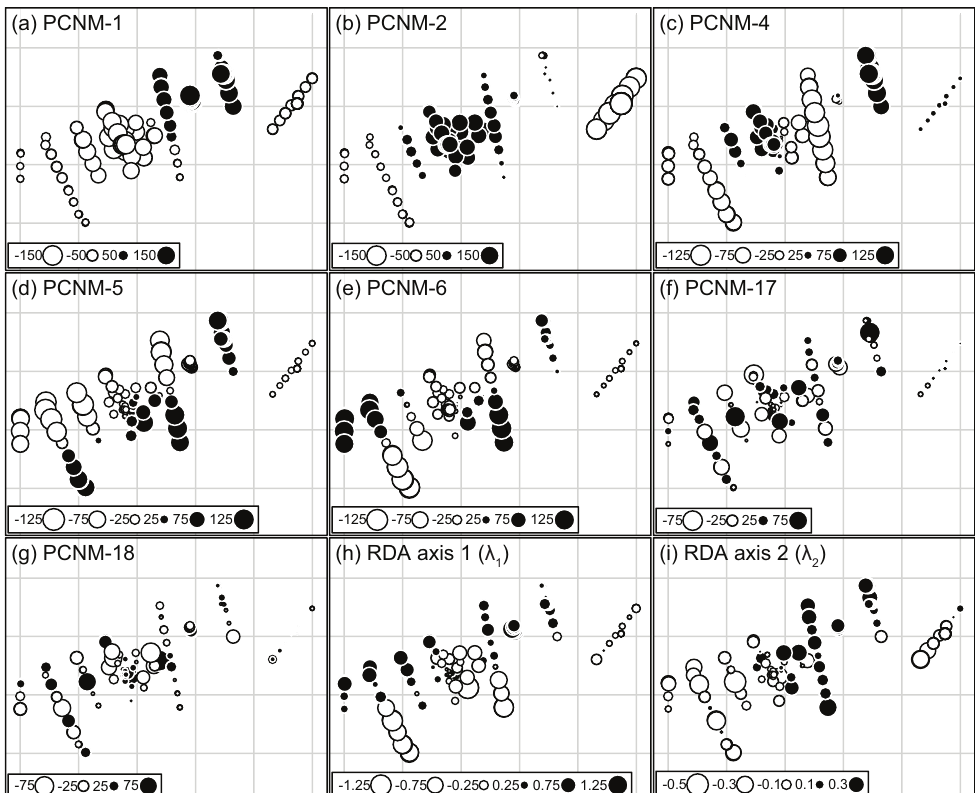
Fig. 15. Maps of (a–g) the seven significant PCNM functions obtained from the analysis between the Euclidean station distance matrix and the vertical POC flux size classes (i.e., used as “species”), and resulting from the forward selection of 25 initial PCNM variables with positive spatial correlation (i.e., positive Moran’s I , across a range of broad-to-fine scales). Maps of (h–i) the fitted scores of the first two canonical axes from the redundancy analysis (representing 44.5% and 5.0% of the total PCNM variance) performed between the POC flux size classes, station locations, and the significant PCNM functions (Fig. 14b). The station locations across the maps correspond to their geographical position as illustrated in Fig. 1. The scale of every PCNM function is zero-centered and corresponds to the distance (km) along an irregular sinusoidal-like waveform function describing the repetition of broad-to-fine scale spatial structures along the X-Y geographic coordinates. The PCNM value of each station (i.e., positive and negative values) corresponds to the fitted value of each POC flux dataset according to these PCNM waveform functions. PCNM: principal coordinates of neighbor matrices (Borcard et al.,